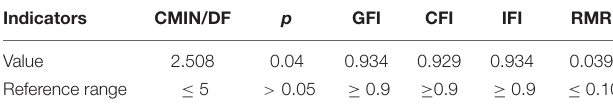
TABLE 3 | Data fitting in the structural equation model.